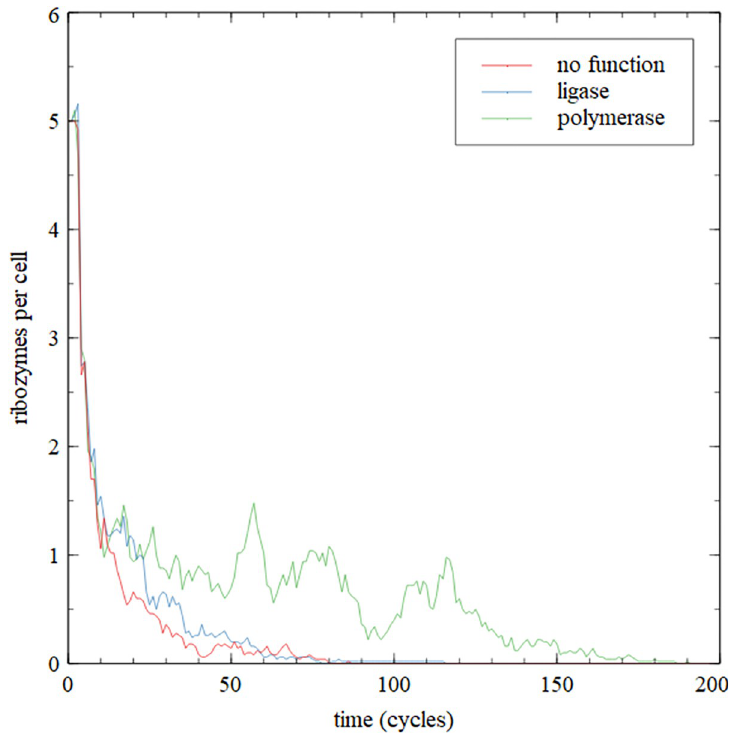
Fig 14. Simulations of a population of 50 cells beginning with 5 copies of the F ribozyme per cell plus fragments and splints. The ribozyme either has no function, or has a beneficial function as a ligase or a polymerase. In all cases the ribozyme is lost due to sequence